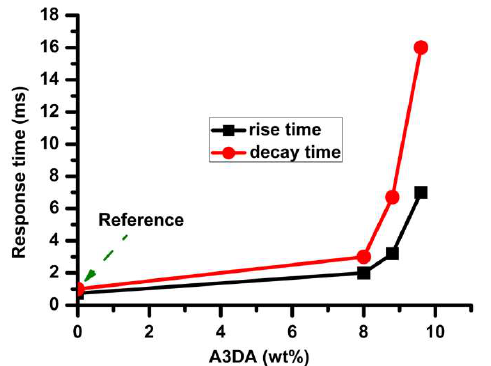
Figure 4. Response times for PDLC films with varied content of A3DA and reference cell.